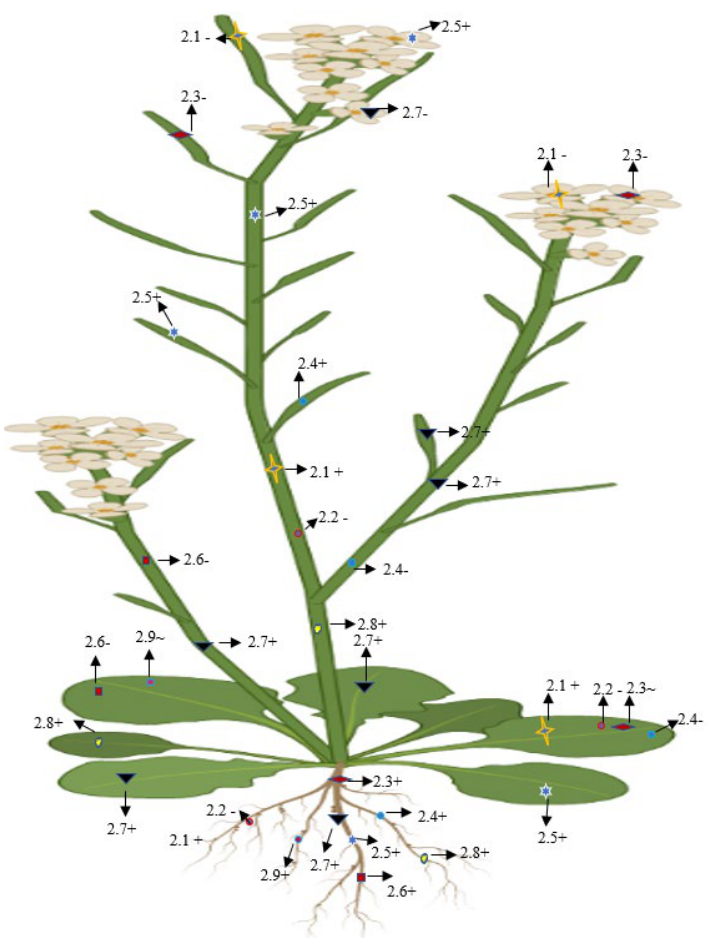
Figure 8. Diagrammatic representation of the presence, absence, and lower expression of Clade II genes in Arabidopsis. + (Expression), (no expression), ~ (low